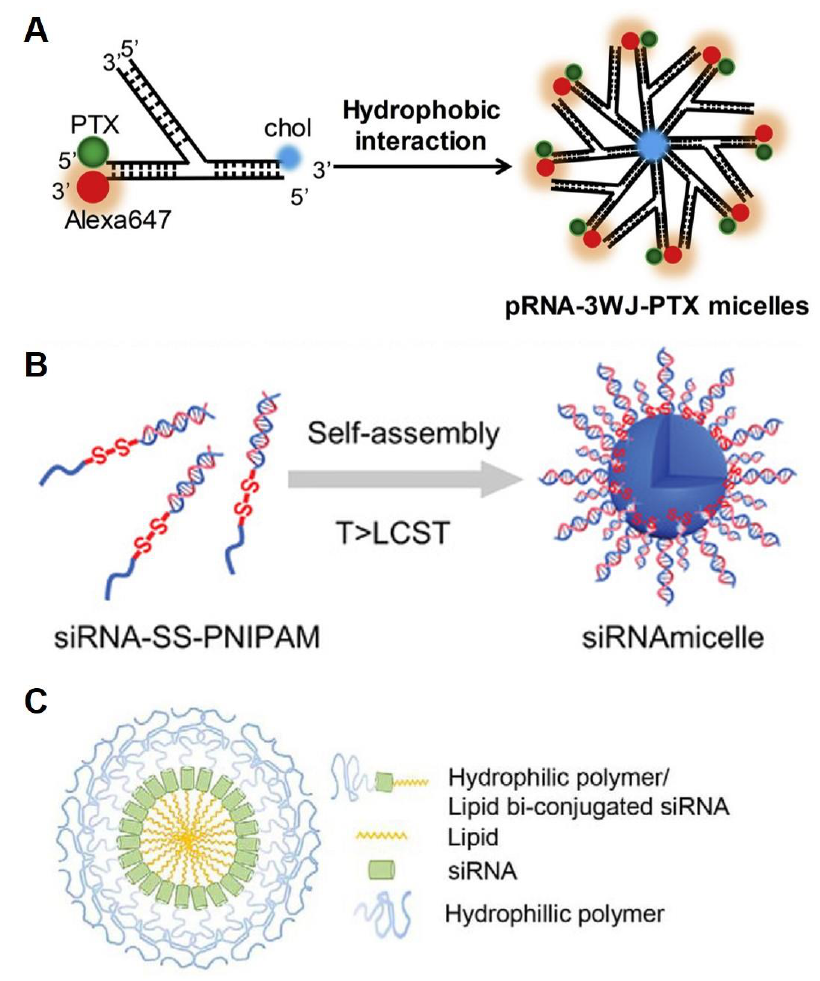
Figure 4. Different types of RNA micelles. ( A ). Schematics of the three-way junction micelles by hydrophobic interaction of cholesterol in aqueous media. Reproduced from ref. [46]. ( B ). Schematic illustration of an RNA micelle. Reproduced from ref. [49]. ( C ). The design of self-assembled micelle inhibitory RNA (SAMiRNA). Reproduced from ref. [50].